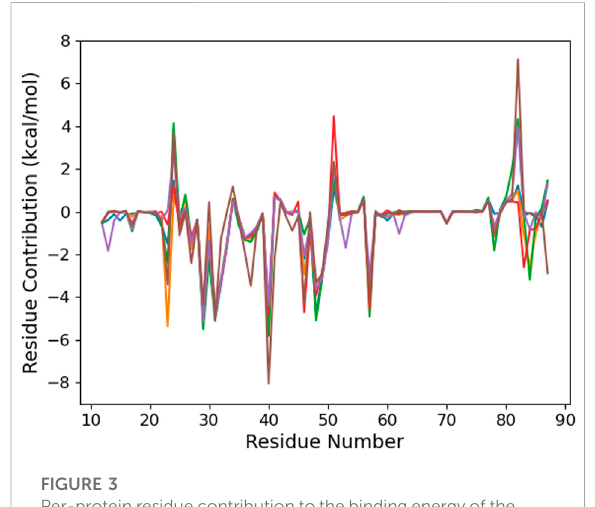
FIGURE 3 Per-protein residue contribution to the binding energy of the RNA fragment for the six studied RNA sequences: control (blue), ° GCCCUG ° G (orange), GCCCU ° GG (green), ° GCCCUGG (red), GCCCUG ° G (violet), and ° GCCC ° GGG (brown).